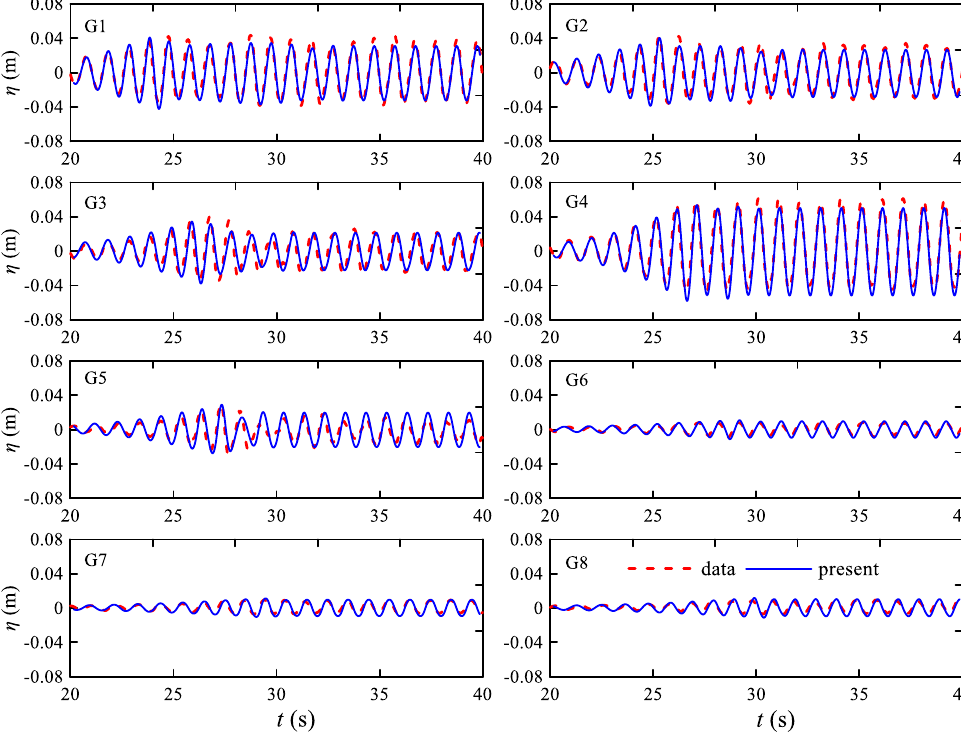
Figure 8. Time series of surface elevation for regular wave propagation in porous structure (Case R2).